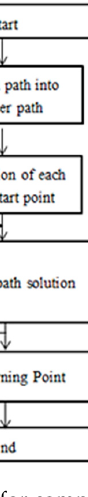
Figure 12. Flow of path programming for complementing the failed path.